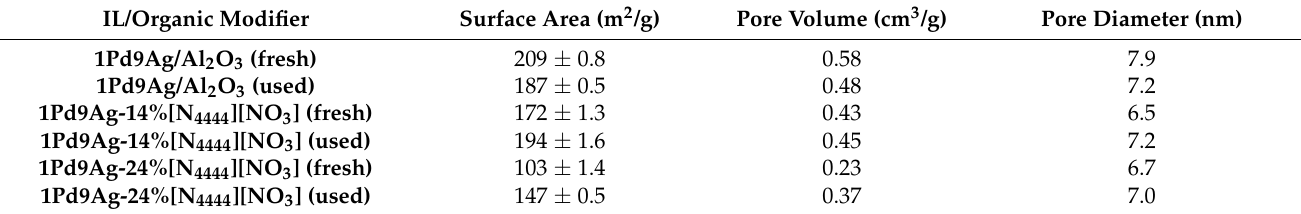
Table 4. Surface area and particle size measurements of all Pd-based